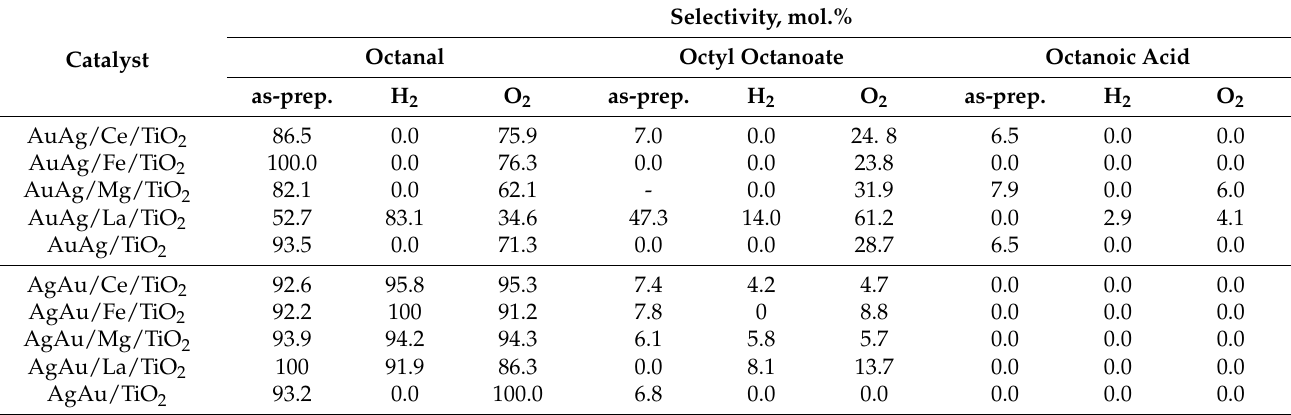
Table 3. Effect of the metal deposition order on the selectivity after 4 h of 1-octanol oxidation for AuAg/M/TiO 2 and AgAu/M/TiO 2, where M is Ce, La, Fe or Mg